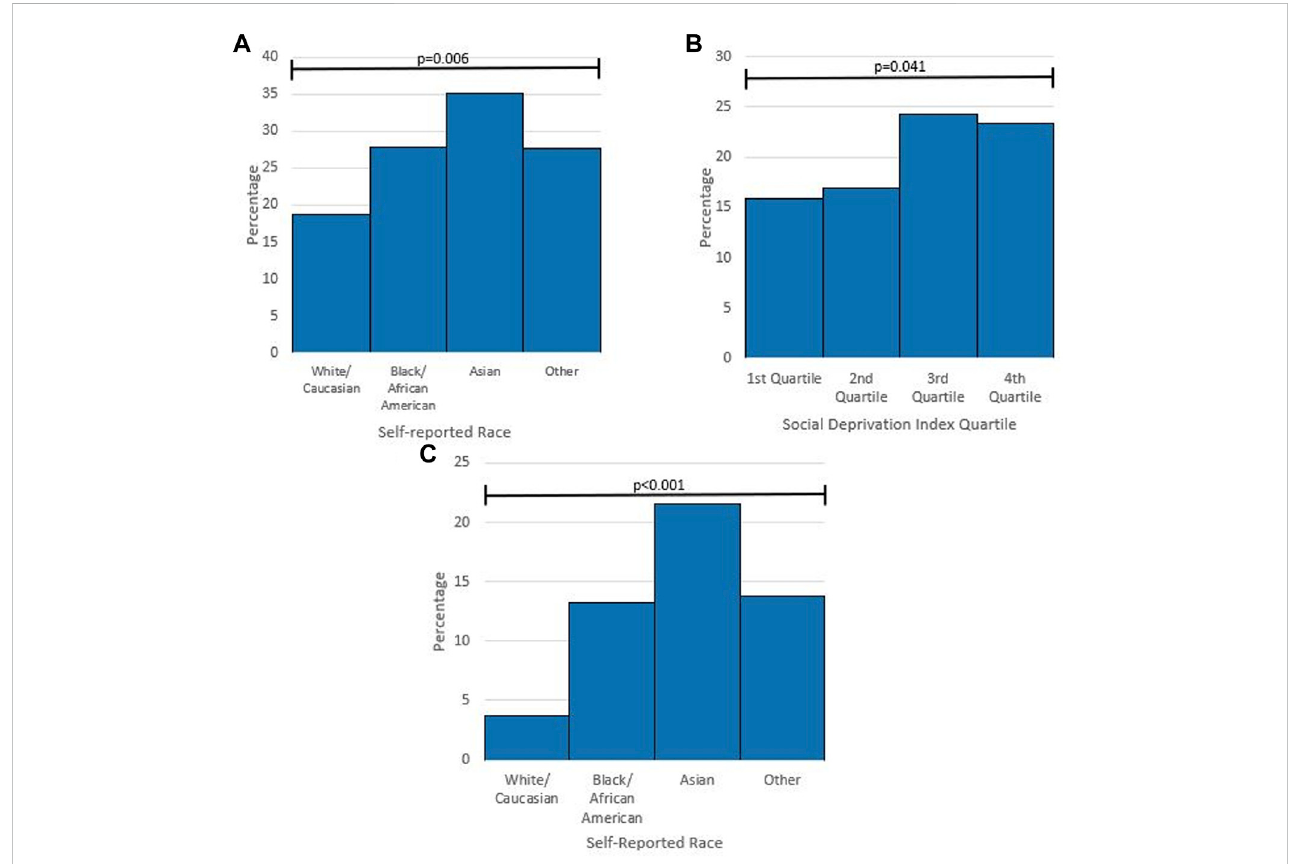
FIGURE 2 Subgroup analysis of pharmacogenetic knowledge and previous pharmacogenetic testing (A) percentage of respondents who had previously heard of pharmacogenetic testing by self-reported race. p -value from Chi-square Test. (B) Percentage of respondents who had previously heard of pharmacogenetic testingbySocialDeprivationIndexQuartile. p -valuefromChi-squareTest. (C) Percentageofrespondentswhohadpreviouspharmacogenetictestingbyself- reported race. p -value from Fisher Exact